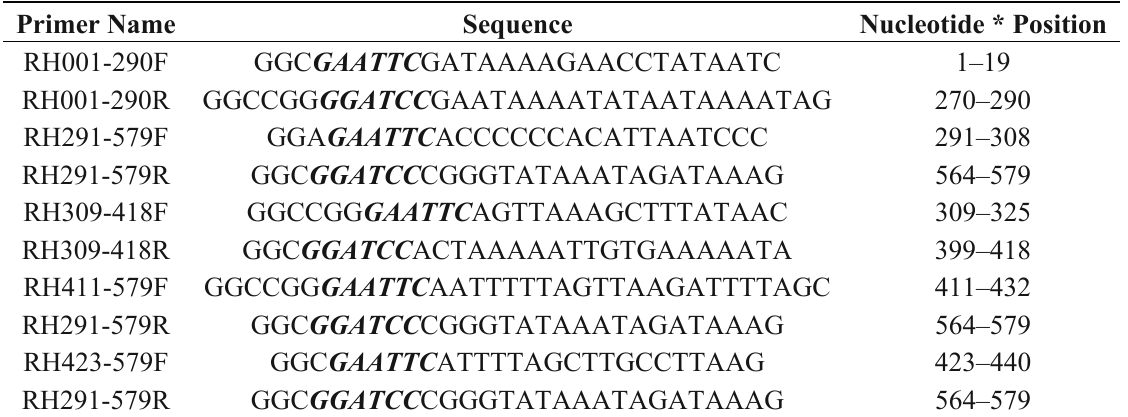
Table 1. Primer sequences used to generate the truncated RhPV